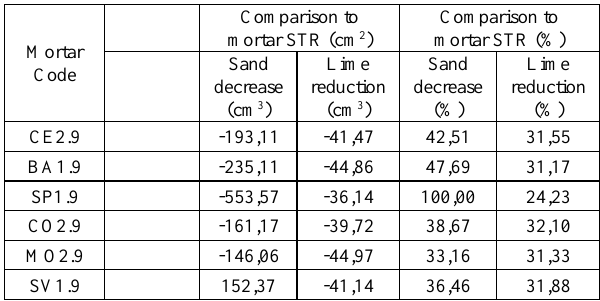
Table 5. Produced earth-based mortars volumes of sand and lime saved, if compared to a standard lime-based mortar (STR). Produced by the